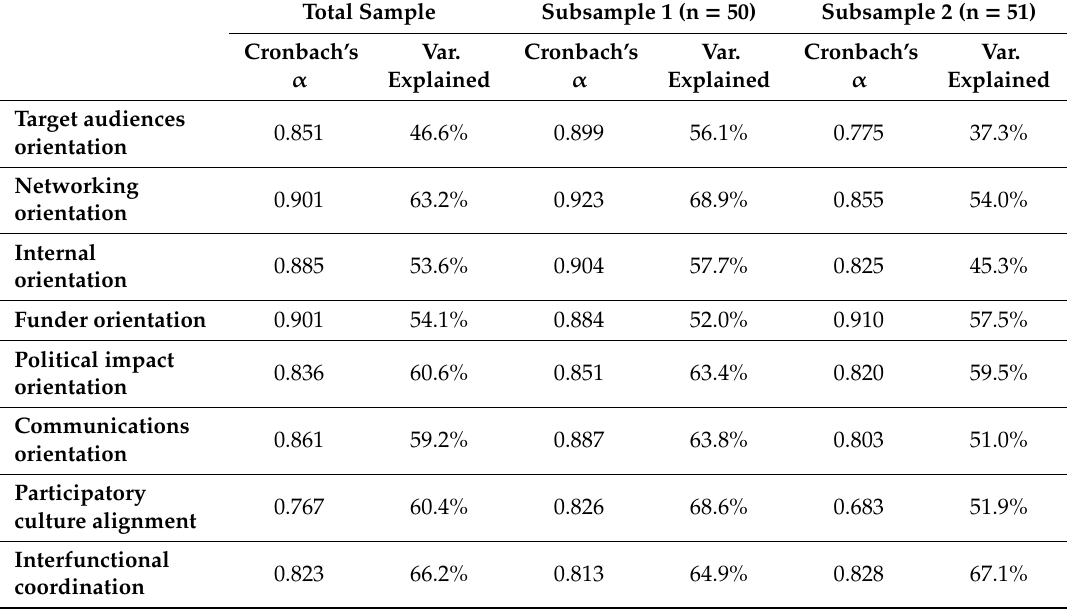
Table 4. Results of the internal consistency